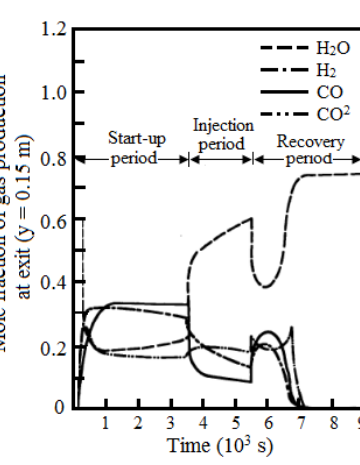
Figure 13. Product gas changes during gasification with midpoint water injection [51].